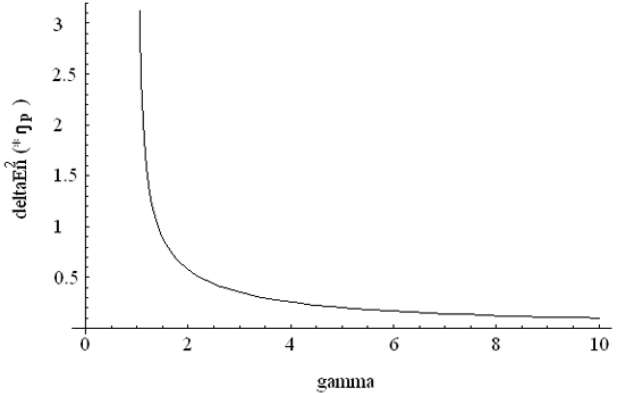
FIG. 4. Dependency of emittance evolution on energy. FIG. 6. (Color) The effect of anode foil on the field distribution near emitter surface.